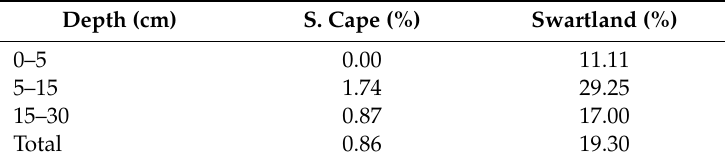
Table 6. Percentage of samples per depth for each region with pH (KCl) ≤